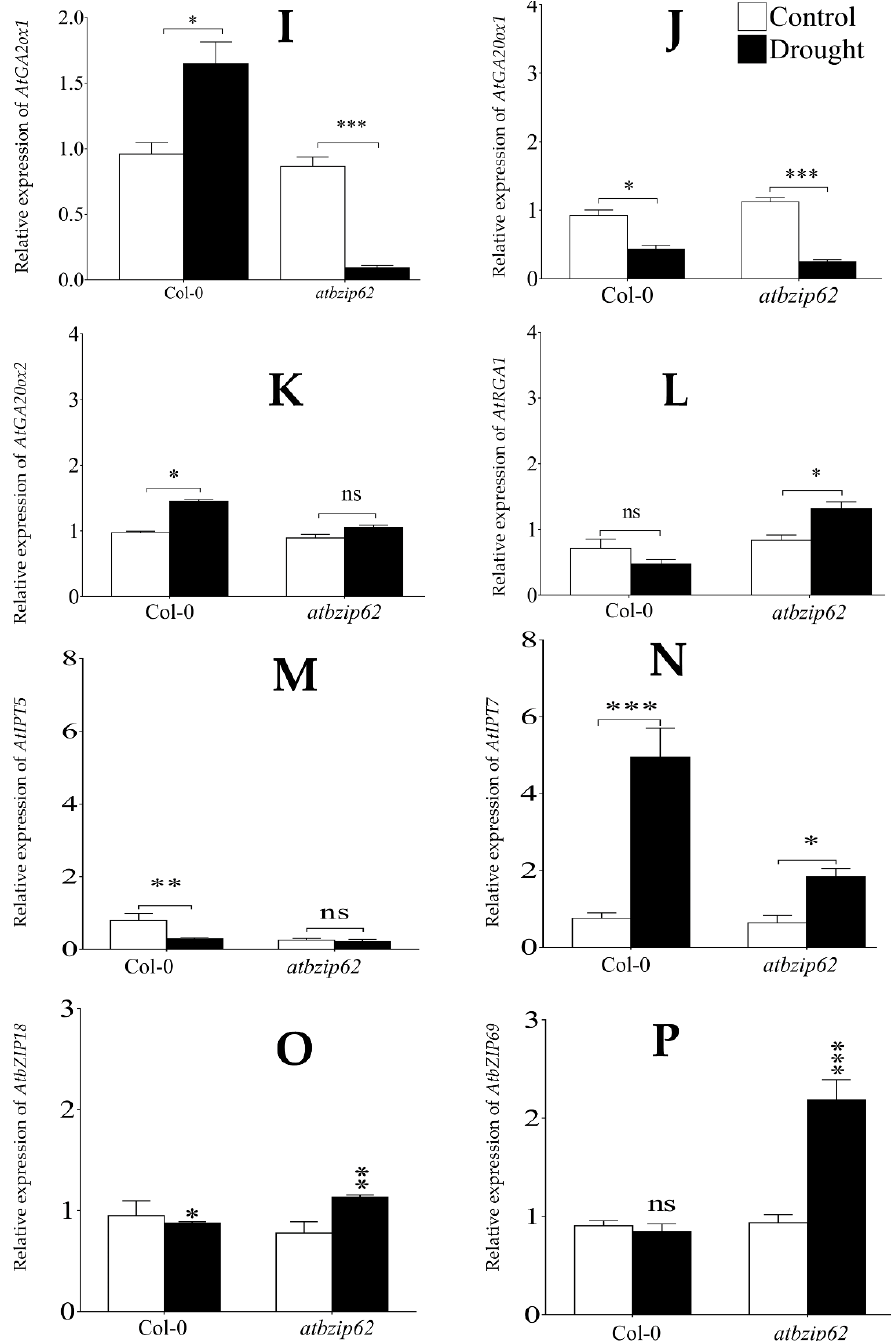
Figure 2. Transcripts accumulation of hormonal responsive genes under drought stress conditions. ( A ) AtPIN1. ( B ) AtPIN3 , ( C ) AtPIN7 , ( D ) AtAXR1 , ( E ) AtMAX1 , ( F ) AtMAX2 , ( G ) AtMAX3 , ( H ) AtMAX4 , ( I ) AtGA2ox1 , ( J ) AtGA20ox1 , ( K ) AtGA20ox2 , ( L ) AtRGA1 , ( M ) AtIPT5 , ( N ) AtIPT7 , ( O ) AtbZIP18 , and ( P ) AtbZIP69 in Arabidopsis Col-0 wild type and atbzip62 knockout plants exposed to drought stress. Bars are mean values ± SE. White bars are controls (routinely watered) plants and black bars are drought-treated plants in triplicate. *** p < 0.001, ** p < 0.01, * p < 0.05, ns non-significant.